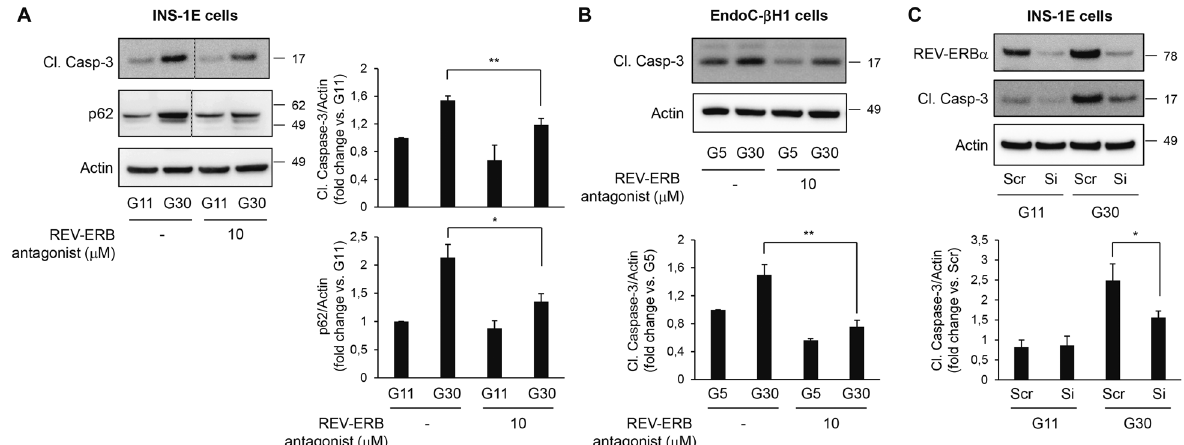
Fig. 7 Negative modulation of REV-ERB α protects β -cells from glucotoxicity-induced apoptosis. INS-1E ( A ) or EndoC- β H1 cells ( B ) were exposed to glucotoxicity [30 mM glucose (G30) vs. control 11 mM glucose (G11)] for 48 h in the presence or absence of REV-ERB antagonist (SR8279, 10 μ M). Cleaved Caspase-3, p62, and actin levels (loading control) were analyzed by western blot ( n = 5 independent experiments for INS-1E; n = 3 independent experiments for EndoC- β H1). C REV-ERB α was silenced in INS-1E cells by siRNA. Scramble RNA (Scr) was used as a control. Cells were then exposed to glucotoxicity for 48 h (G30 vs. G11). Levels of REV-ERB α , Cl. Caspase-3, and actin were analyzed by western blot ( n = 4 independent experiments). For p62 and Cl. Caspase-3 images, lanes were run on the same gel but were non-continuous